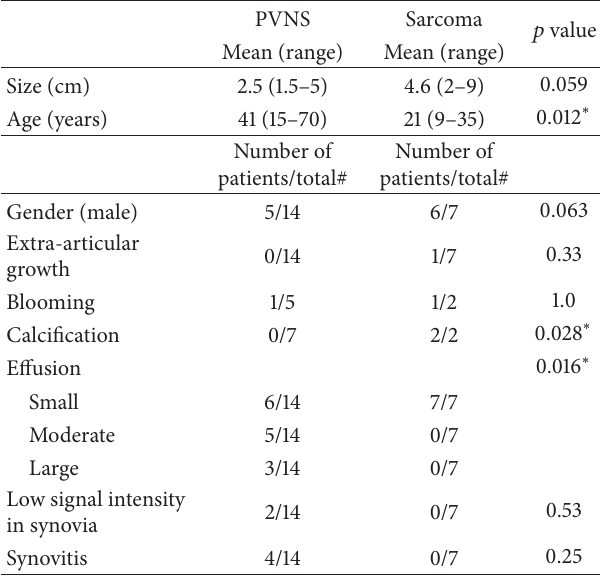
Table 2: Univariate data analysis.